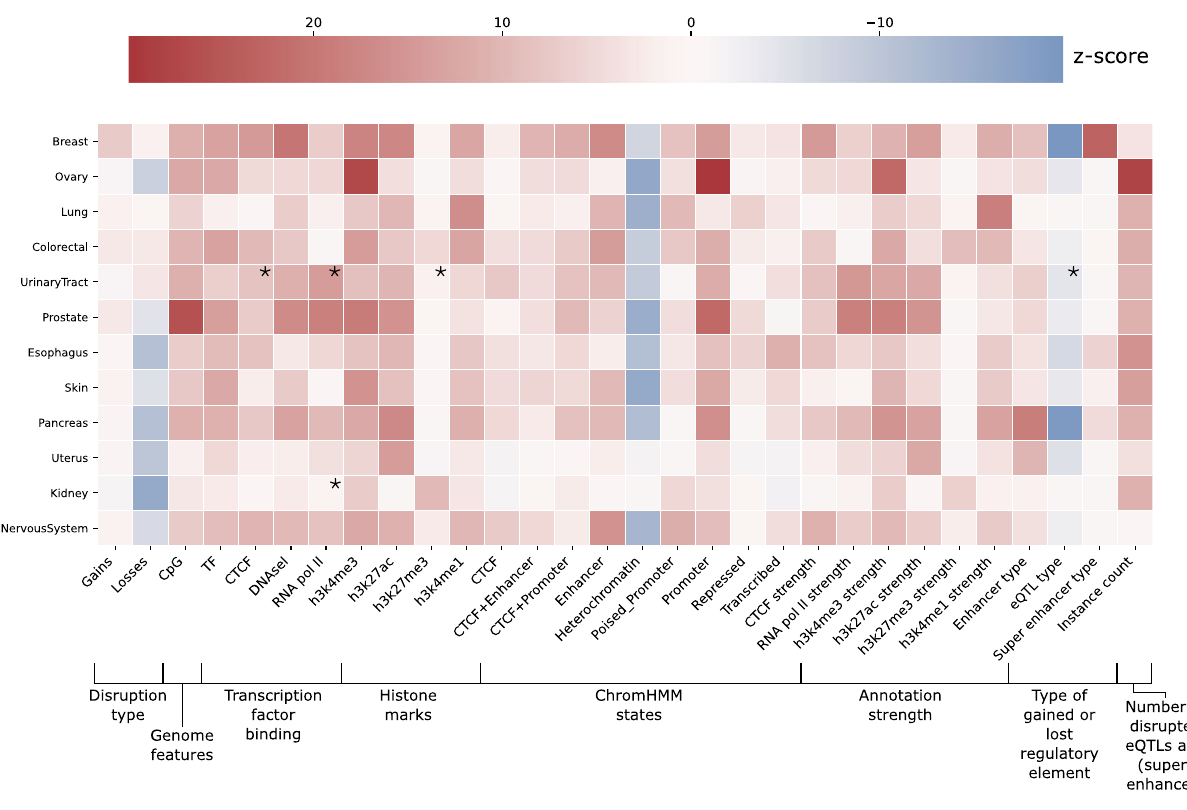
Figure 3. Heatmap showing the instances observed more (red) or less (blue) frequently than expected by random chance in each cancer type. The colors represent the z-score. The asterisks indicate regulatory elements that were missing in a cancer type and for which GM12878 was used as default.